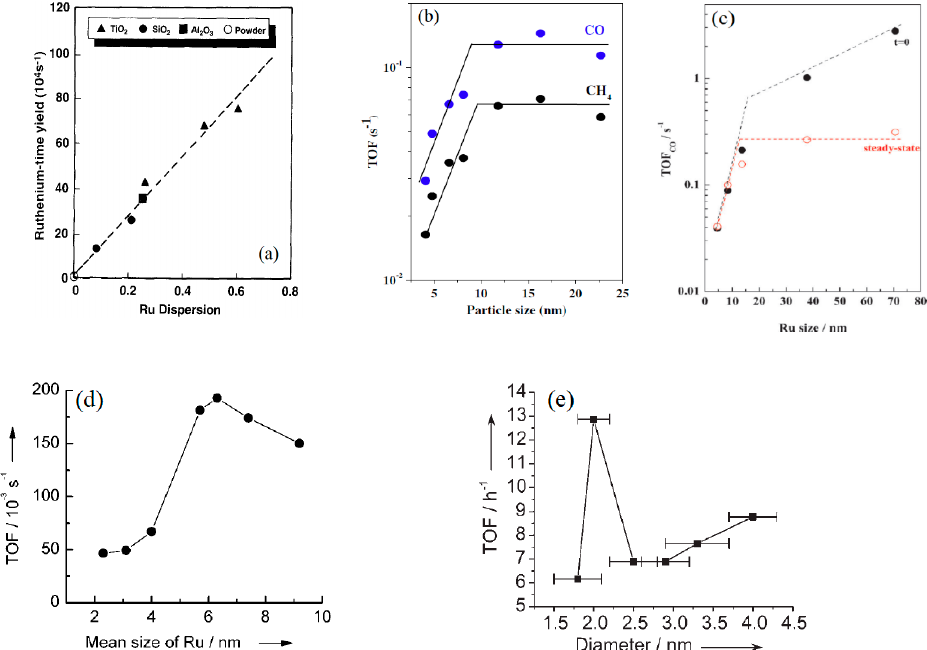
Figure 6. ( a ) Effects of ruthenium dispersion on Fischer–Tropsch synthesis rates at 203 ◦ C, H 2 /CO = 2.1, 0.56MPa, 45–60% CO conversion (reproduced with permission from [8] Copyright 1992, Academic Press. Inc.), ( b ) Effects of Ru particle size on turnover frequencies for CO consumption and CH 4 formation rates at 250 ◦ C; 0.2 MPa, H 2 /CO = 1 (reproduced with permission from [7] Copyright 2011, Elsevier), ( c ) Evolution of TOF CO with Ru particle size at the beginning of the reaction, t = 0, and after 20 h on stream, steady-state regime (reproduced with permission from [57] Copyright 2014, Wiley-VCH Verlag GmbH & Co.), ( d ) Dependence of TOF on the mean size of Ru particles at 260 ◦ C; 2 MPa, H 2 /CO = 1 (reproduced with permission from [58] Copyright 2009, Wiley-VCH Verlag GmbH & Co.), ( e ) TOF as a function of diameter of the Ru nanoparticles at 150 ◦ C; 3 MPa, H 2 /CO = 2 (reproduced with permission from [59] Copyright 2008, Wiley-VCH Verlag GmbH &